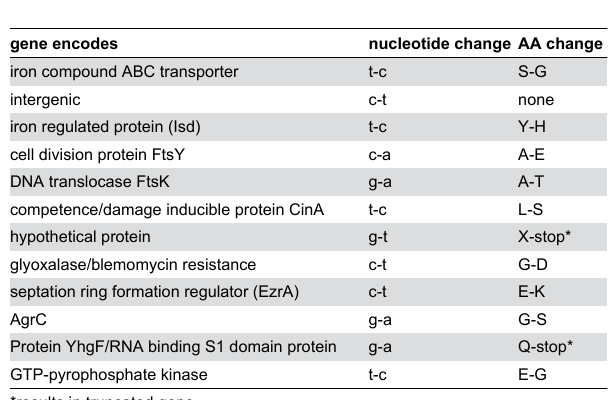
Table 2. Mutations between S0460 and S0462.